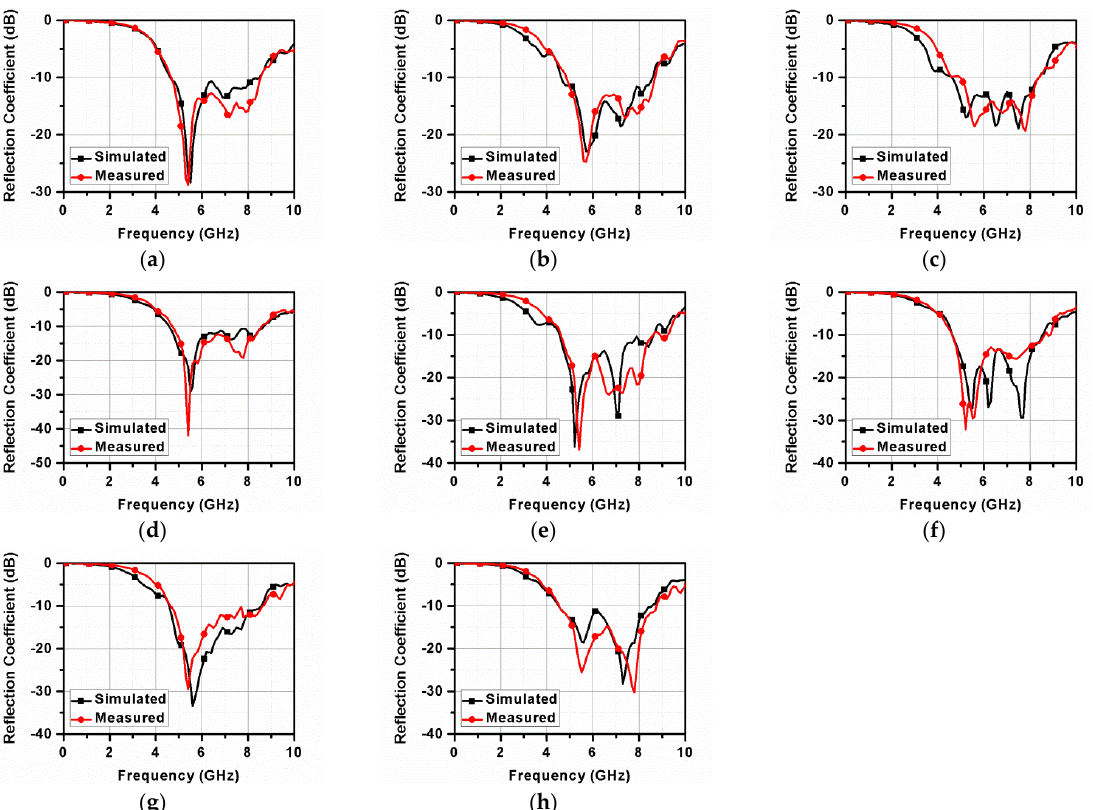
Figure 19. Plot of ( a ) S 10 10, ( b ) S 11 11, ( c ) S 12 12, ( d ) S 13 13, ( e ) S 14 14, ( f ) S 15 15, ( g ) S 16 16, ( h ) S 17 17.